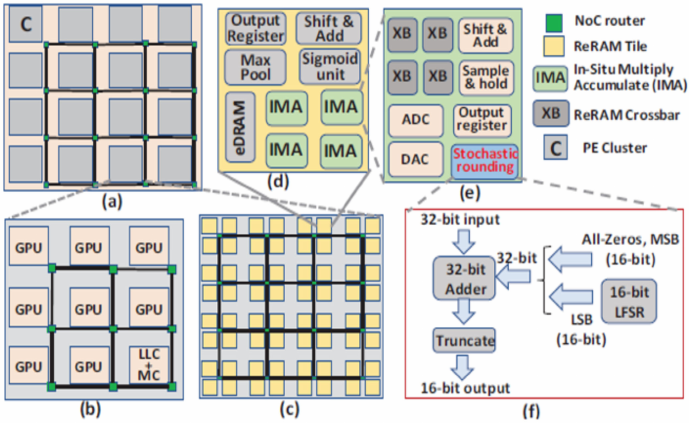
Figure 2. Proposed GRAMARCH architecture [15]. (Reprinted with permission from ref. [15]. Copy- right 2021 IEEE). ( a ) Top view of proposed architecture, ( b ) Lower logic layer, ( c ) Upper ReRAM layer, ( d ) ReRAM tile, ( e ) In-situ Multiply Accumulate (IMA) and ( f ) Stochastic rounding